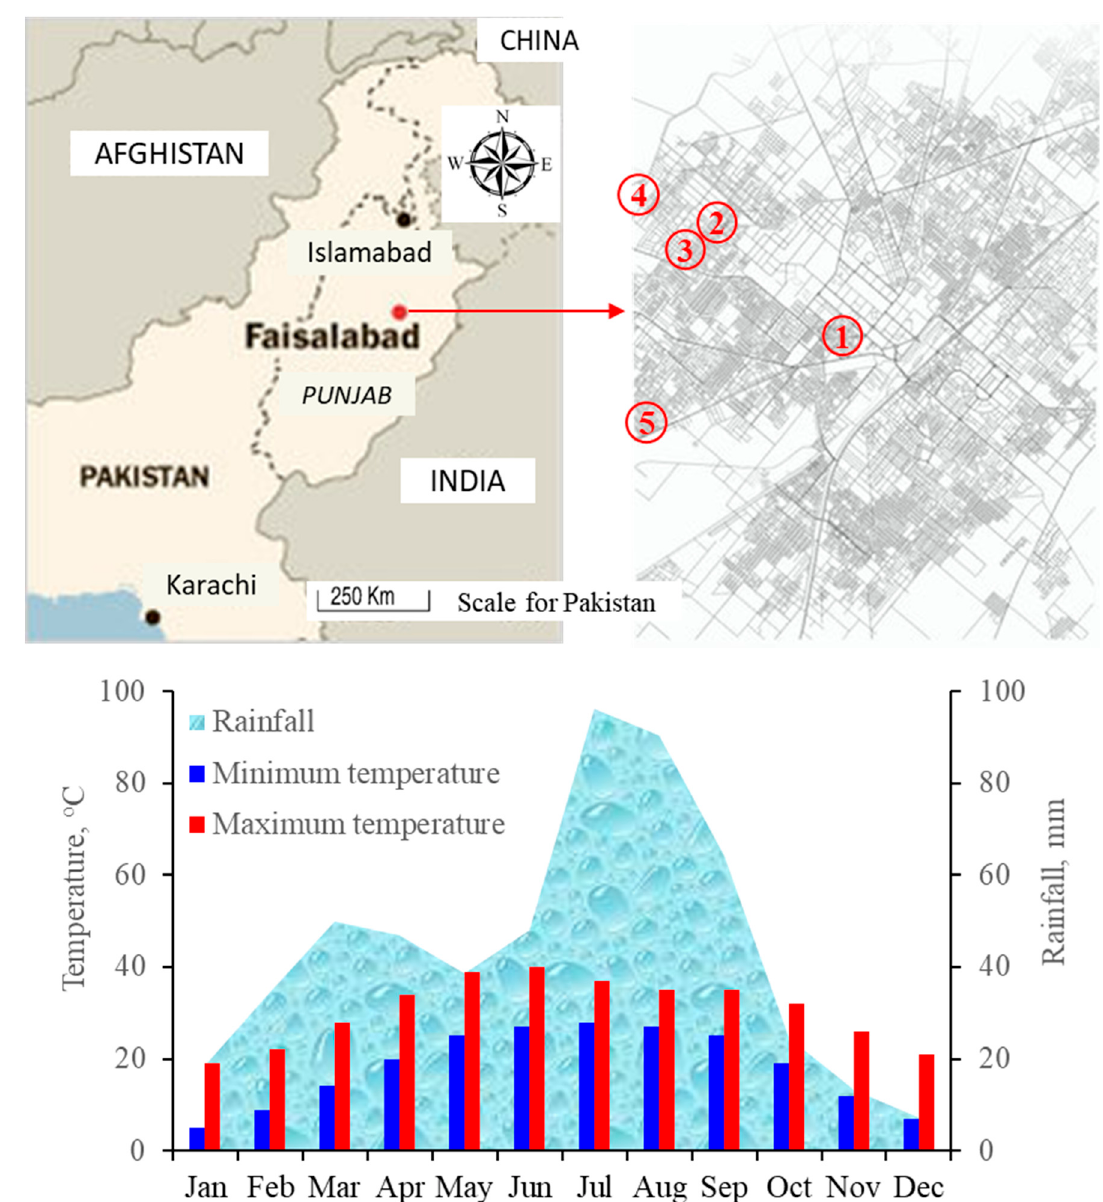
Figure 2. The geographic location of Faisalabad city and the five low-income communities (top) the past 50-year record of monthly means for rainfall, minimum temperature, and maximum temperature for the Faisalabad region.